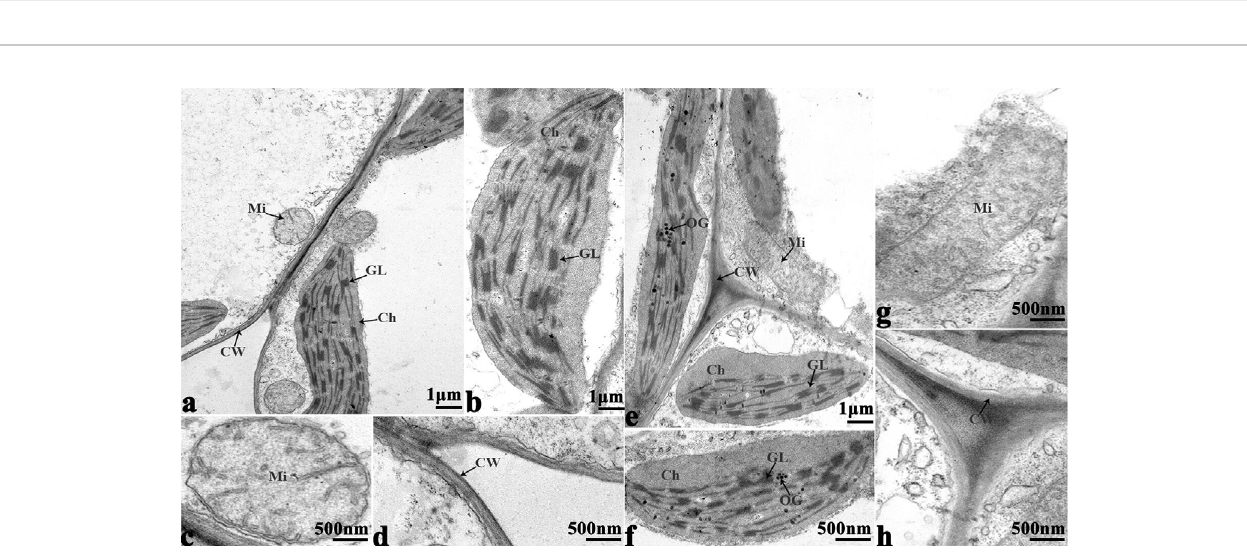
FIGURE 9 | Transmission electron micrographs of leaf ultrastructure from cultivar 16NTS309 under non-cold (A – D) and cold stress (E – H) conditions for 48 h. Mi, mitochondria; Ch, chloroplast; GL, granum lamellae; OG, osmiophilic globule; CW, cytoderm.Scale bars = 1 µm and 500 nm.